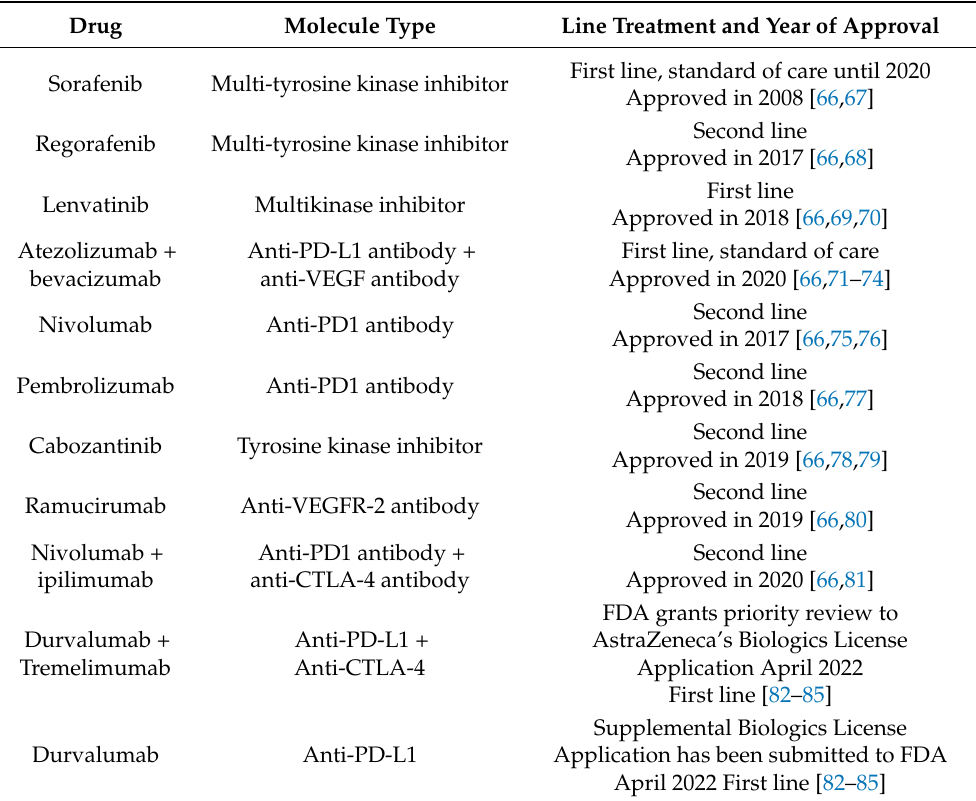
Table 1. Systemic therapies for advanced